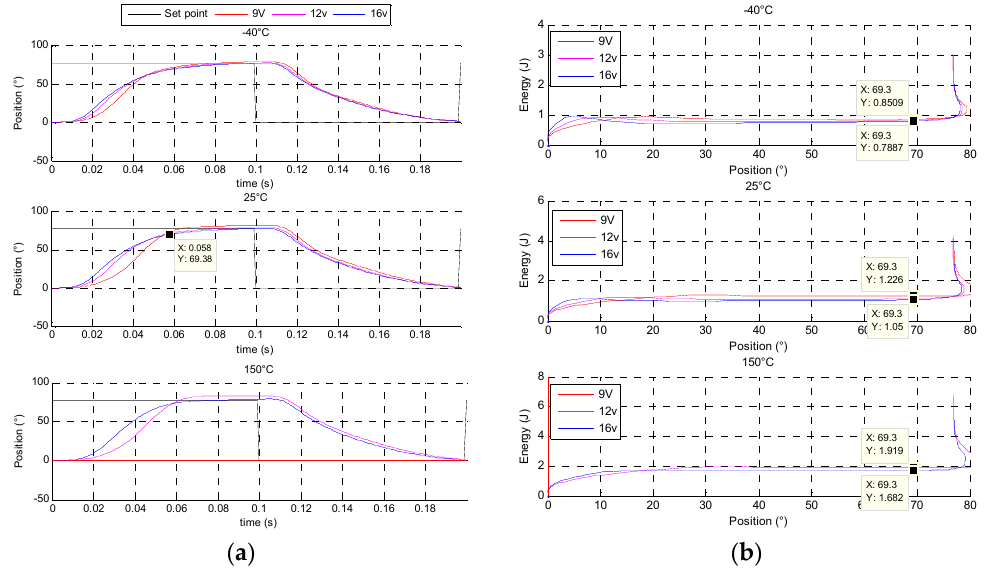
Figure 20. ( a ) Increasing and decreasing position step response of direct drive actuator at 25 °C; ( b ) Electrical energy consumption in increasing position step of direct drive actuator at 25 °C.